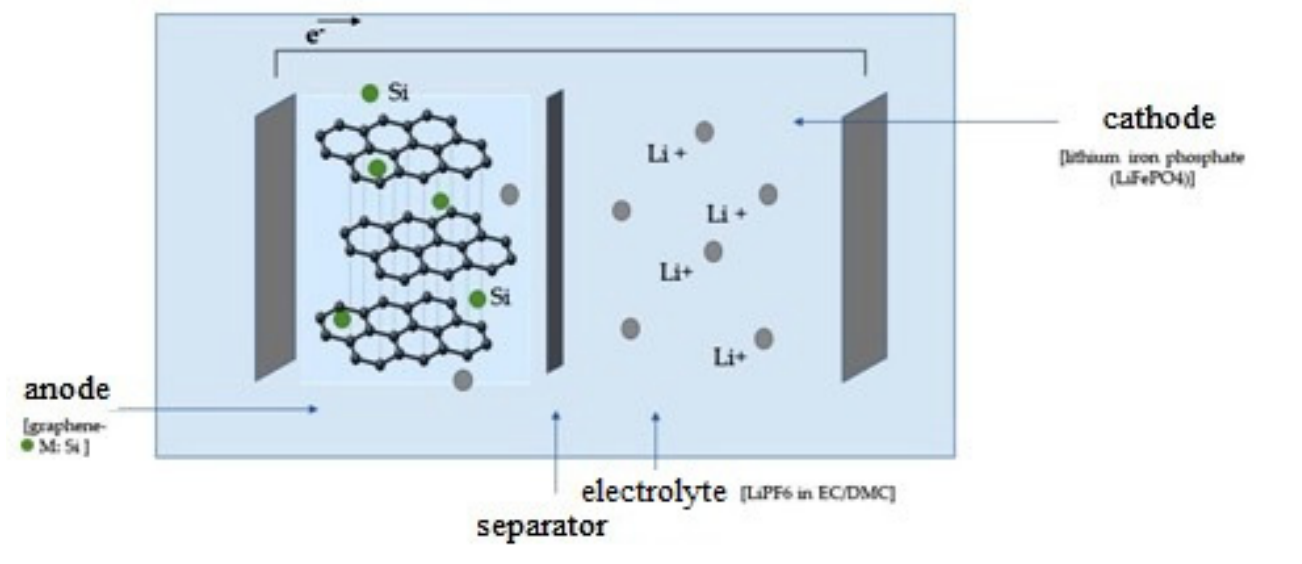
Figure 1. A simple battery system with a graphene/Si composite as the anode and a lithium iron phosphate as the cathode.